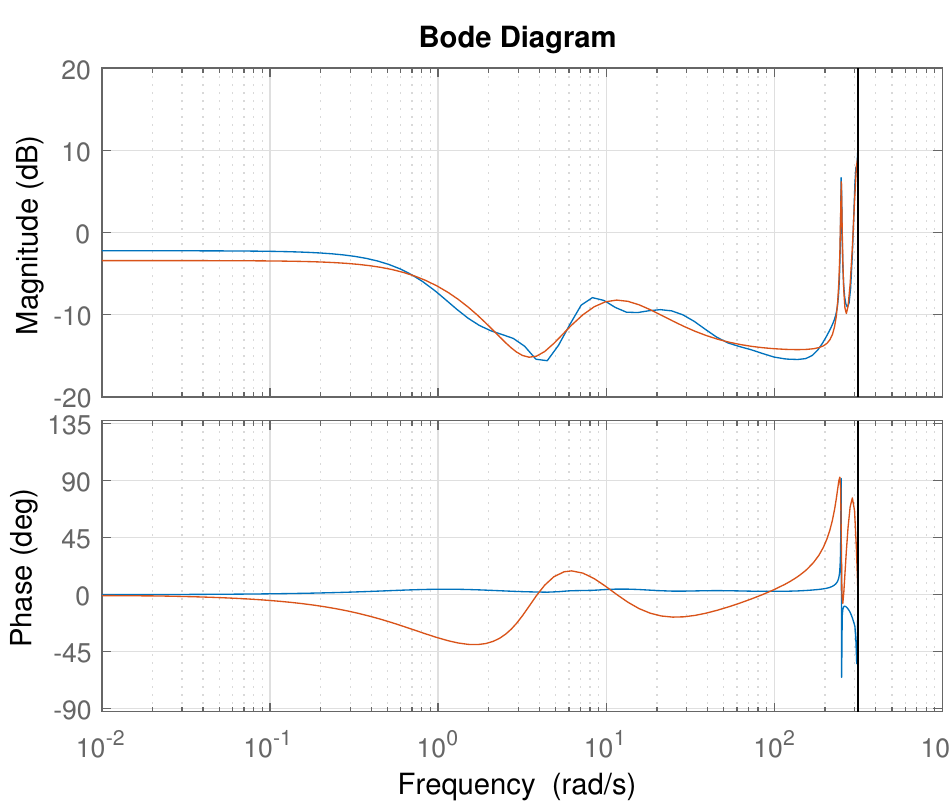
Figure 7. Frequency domain approximation of confidence intervals in Box-Jenkins model with rational transfer